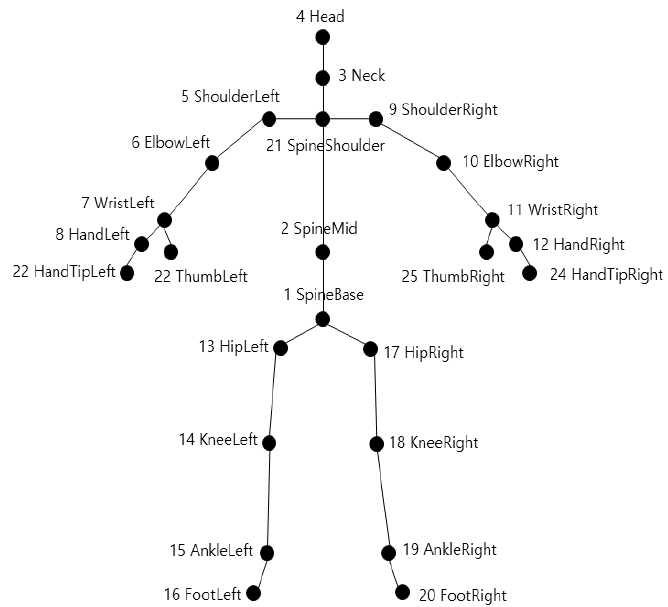
Figure 7. Skeleton joint position of Kinect v2.